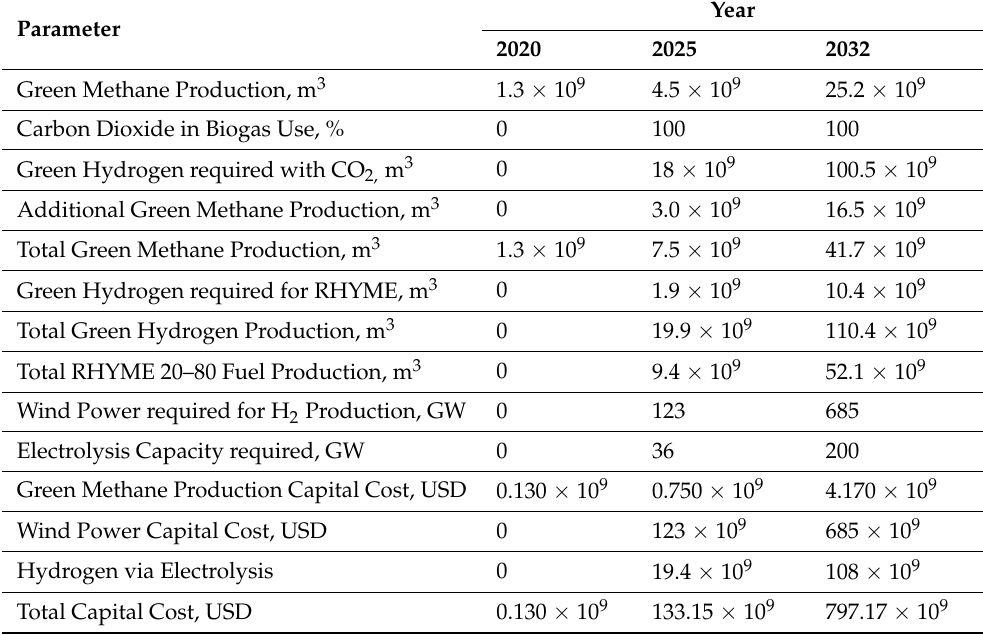
Table 9. Short term introduction of green hydrogen in transportation through the implementation of the RHYME 20–80 fuel in the United